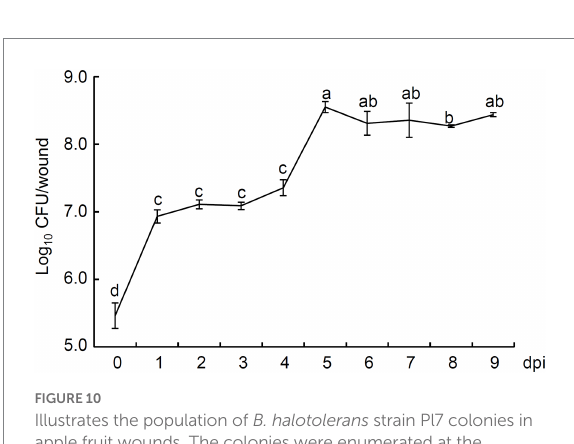
FIGURE 10 Illustrates the population of B. halotolerans strain Pl7 colonies in apple fruit wounds. The colonies were enumerated at the indicated time points, and each time point consisted of three replicates. The population density was converted as Log10 CFU/ wound. Data are presented as the mean ± SD of three biological replicates. Different lowercase letters represent significantly different means at p < 0.05 (Duncan’s multiple test). The experiment was performed independently two times with similar